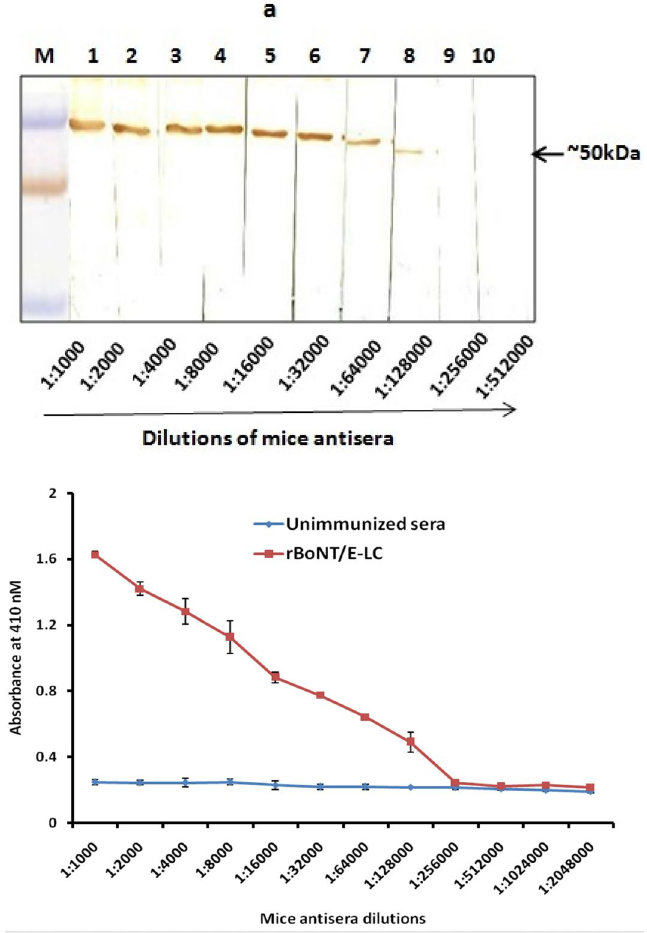
Figure 3. ( A ). Western blot showing the dilution series of antisera raised in mice immunized with rBoNT/ E-LC. Lane 1: molecular weight marker indicated to the left; lane 2–11: mice antisera serially diluted from 1:1,000 to 1:512,000 ( B ). Titration curves showing indirect ELISA of mice antiserum that was serially diluted (1:1,000 to 1:2,048,000) and tested against 500 ng/mL of purified rBoNT/E-LC. Data are presented as the mean absorbance ± SD from triplicate wells. Antibody titre was detected upto dilution of 1:128,000 in western blot and 1:256,000 in ELISA,